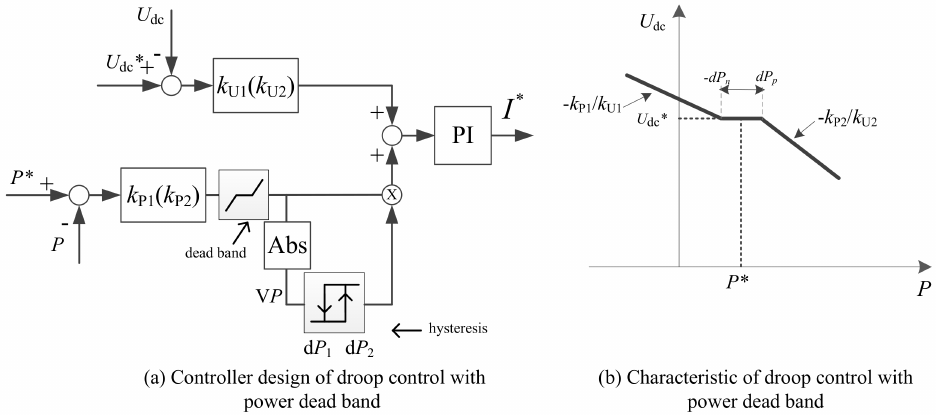
Figure 6. Droop controller design with the additional power dead